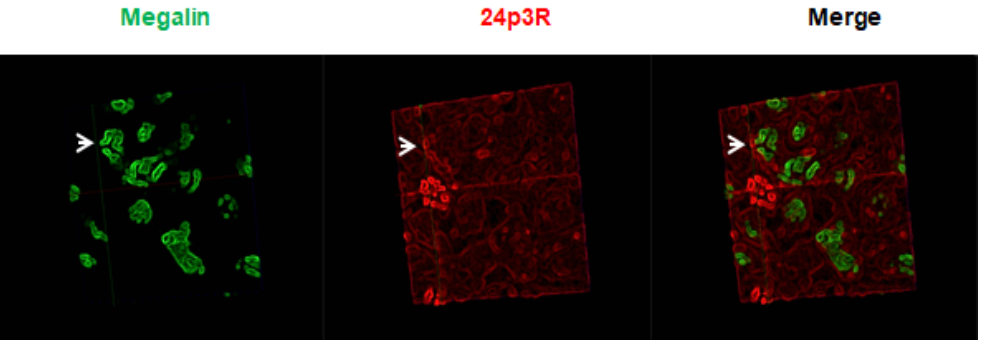
Figure 7. Expression of megalin in PT does not colocalize with 24p3R. Representative micrographs of the expression pat- tern of 24p3R (red) of kidney samples from the control group. Megalin (green): Specific protein of the PT. 40× objective. White arrows show that megalin positive cells do not express 24p3R.